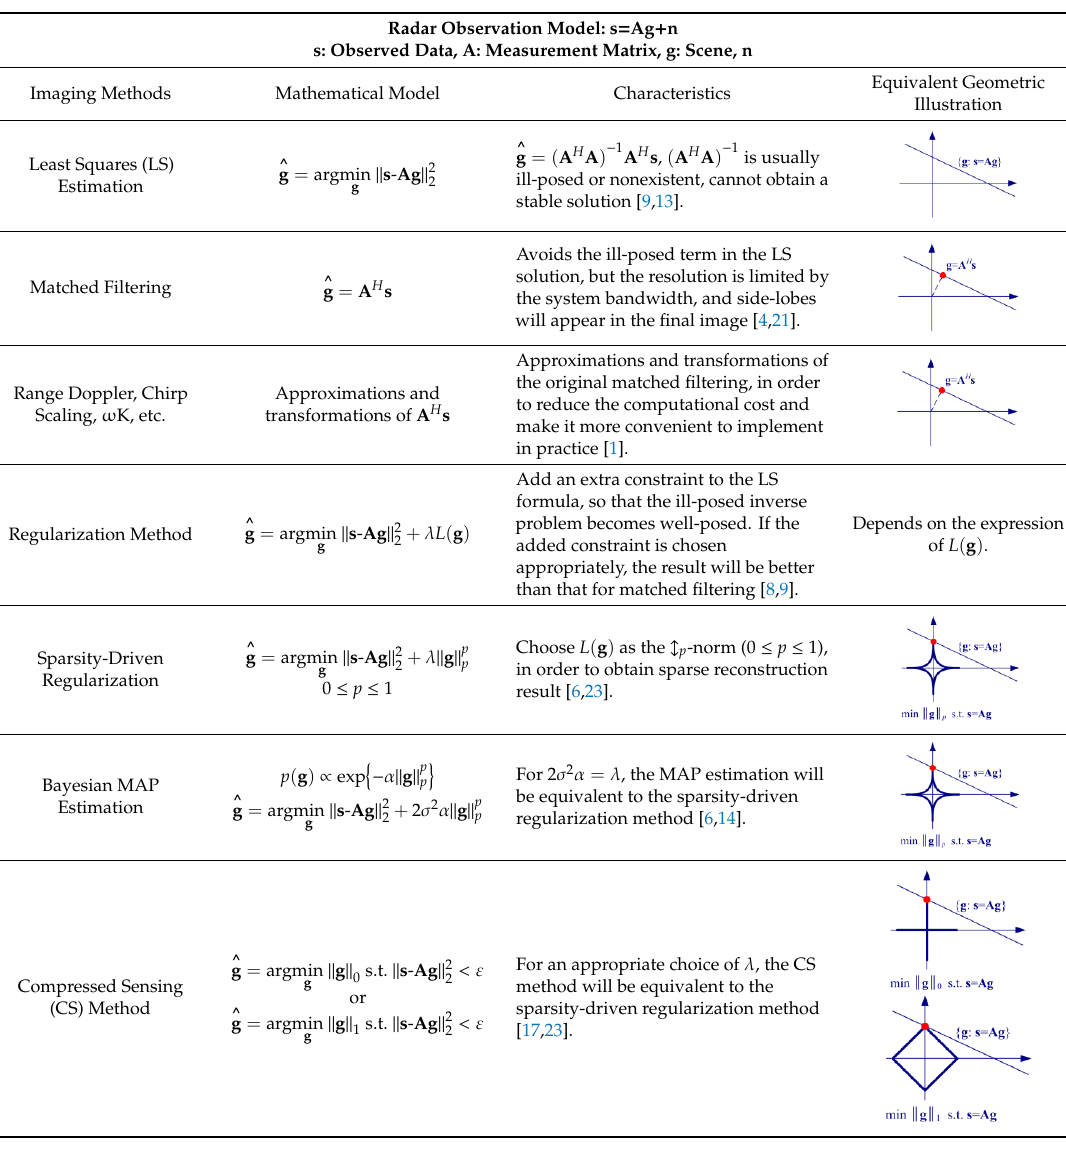
Table 1. Characteristics and connections of radar imaging methods.